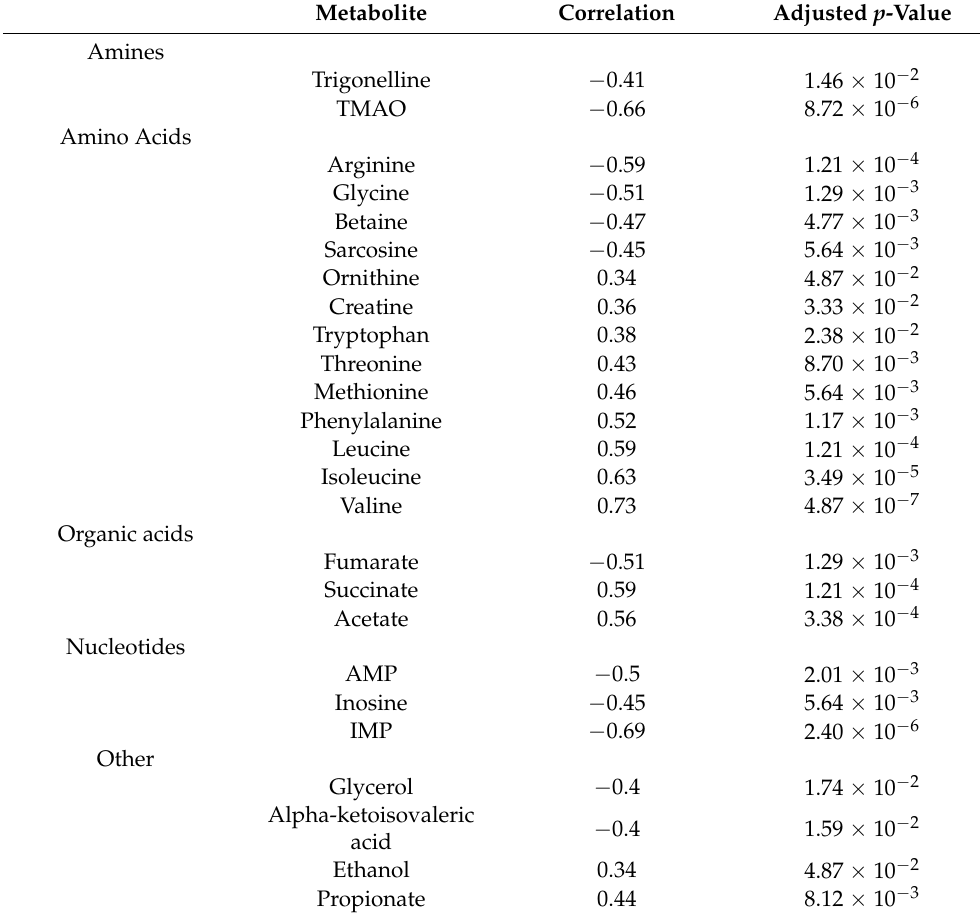
Table 3. Correlations between total mesophilic bacteria (TMB) and the metabolite concentrations in striped prawns during chilled